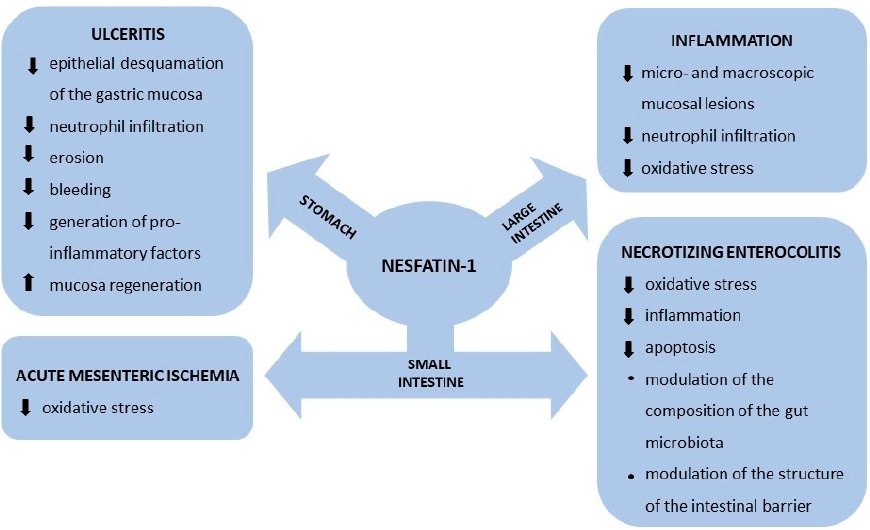
Figure 2. The effect of nesfatin-1 in selected GIT disorders.